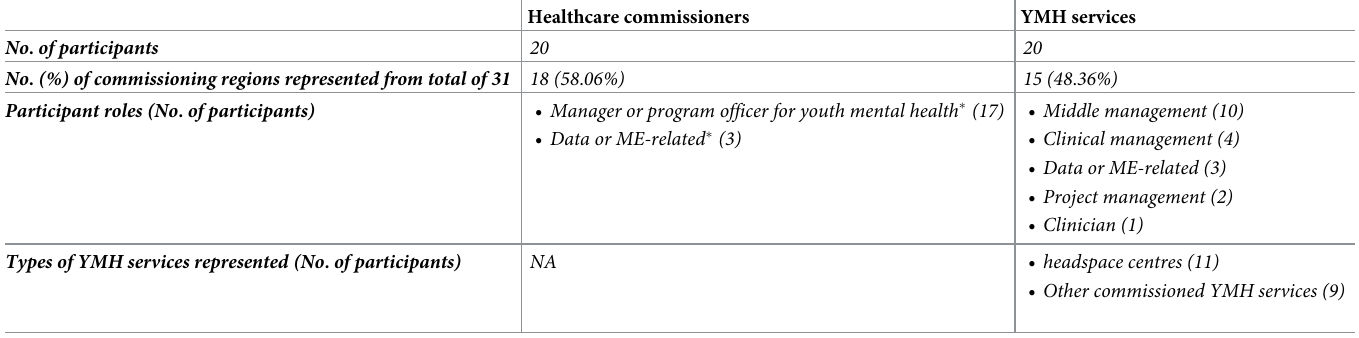
Table 1. Participant characteristics.